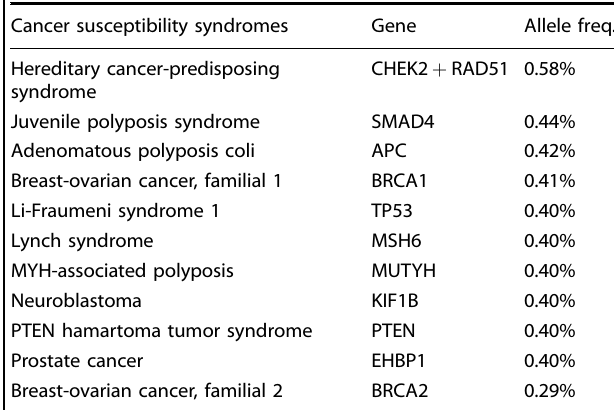
Table 2. Recessive genetic disorders with the highest carrier rates in the TWB cohort.